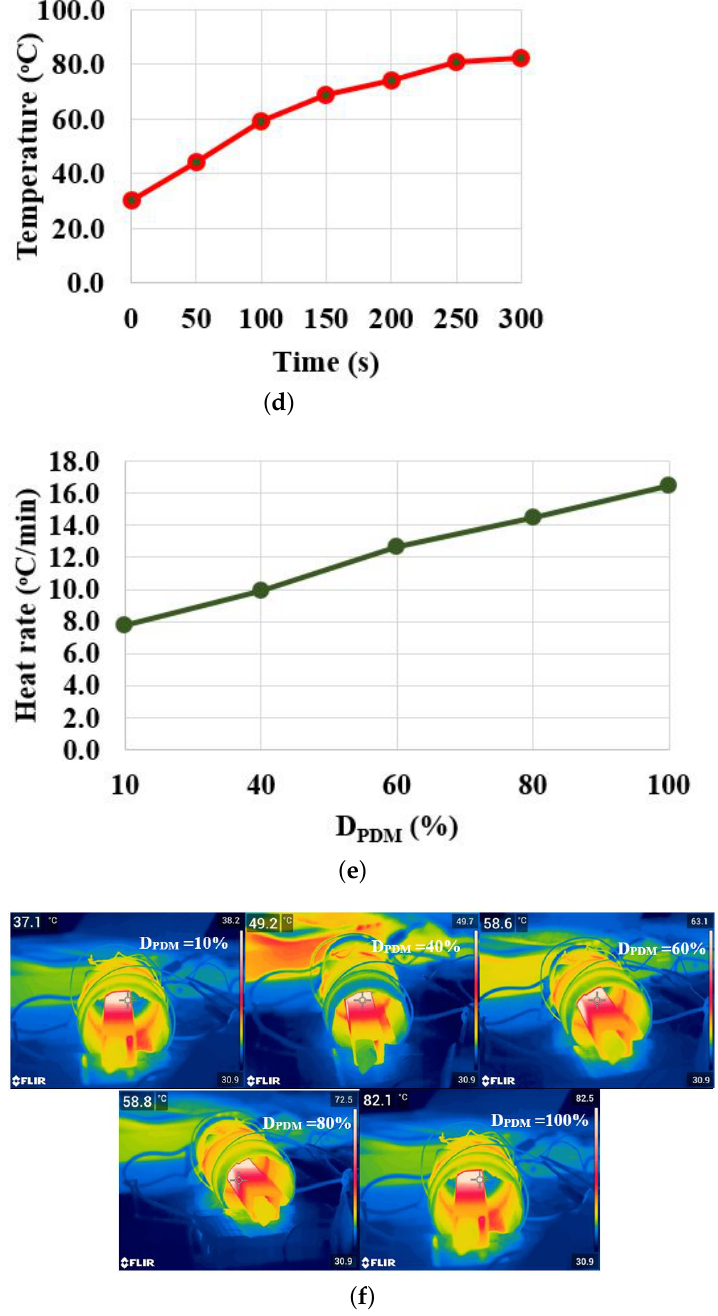
Figure 11. Pulse density modulation control. ( a ) Switching pulses for D PDM = 60%. ( b ) Output voltage and current waveforms for D PDM = 60%. ( c ) output voltage and current waveforms for D PDM = 90%. ( d ) Temperature variation. ( e ) Heat rate for various D PDM . ( f ) FLIR thermal image for various D PDM at t = 5